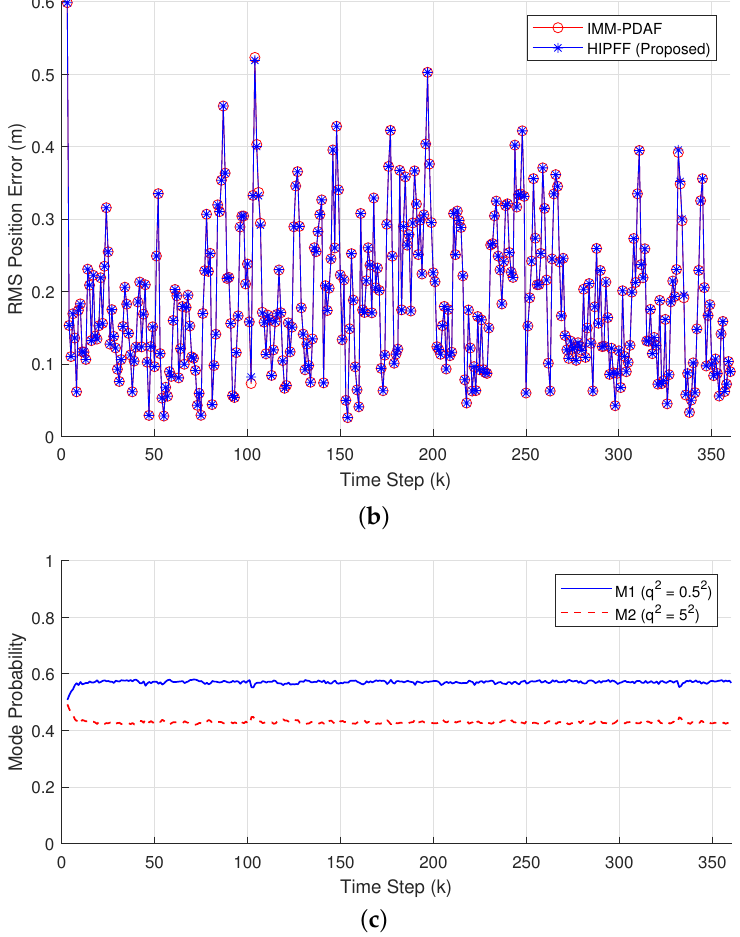
Figure 8. Results of 3D localization using IMM-PDAF and HIPFF when both algorithms work well: ( a ) trajectory of mobile node, ( b ) RMS position error and ( c ) mode